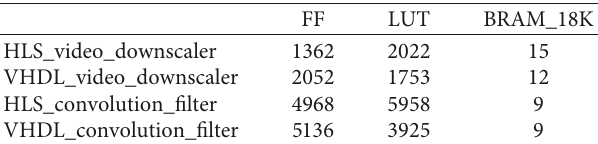
Table 7: Comparing HLS and hand-written VHDL implementa- tions for video downscaler (16:1) and convolution